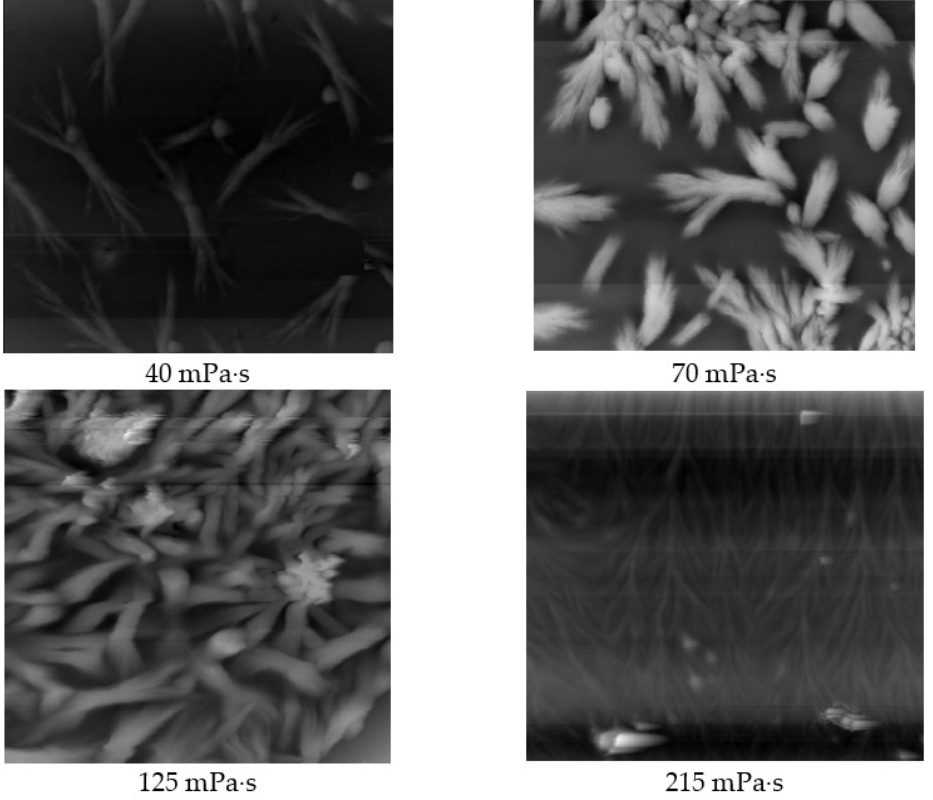
Figure 6. Structure and morphology of polymer solutions with different viscosities (20 μ m × 20 μ m).